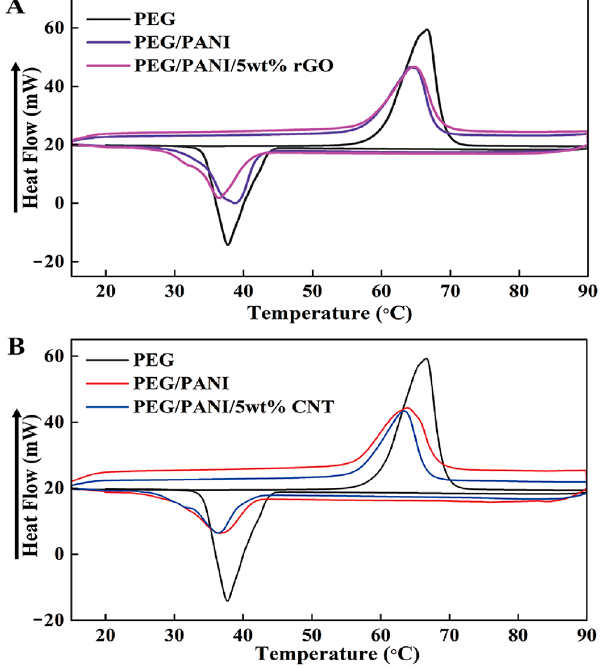
Figure 4. ( A ) PANI supported rGO/PEG composite, and ( B ) PANI supported CNT/PEG composite. ( C ) Variation of electrical resistivity under the change of temperature.